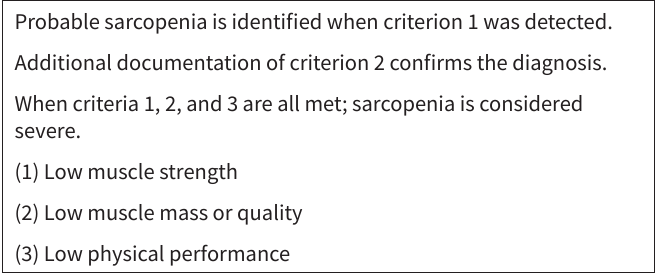
Table 1. Sarcopenia diagnostic criteria (EWGSOP, 2018) Probable sarcopenia is identified when criterion 1 was detected. Additional documentation of criterion 2 confirms the diagnosis. When criteria 1, 2, and 3 are all met; sarcopenia is considered severe.